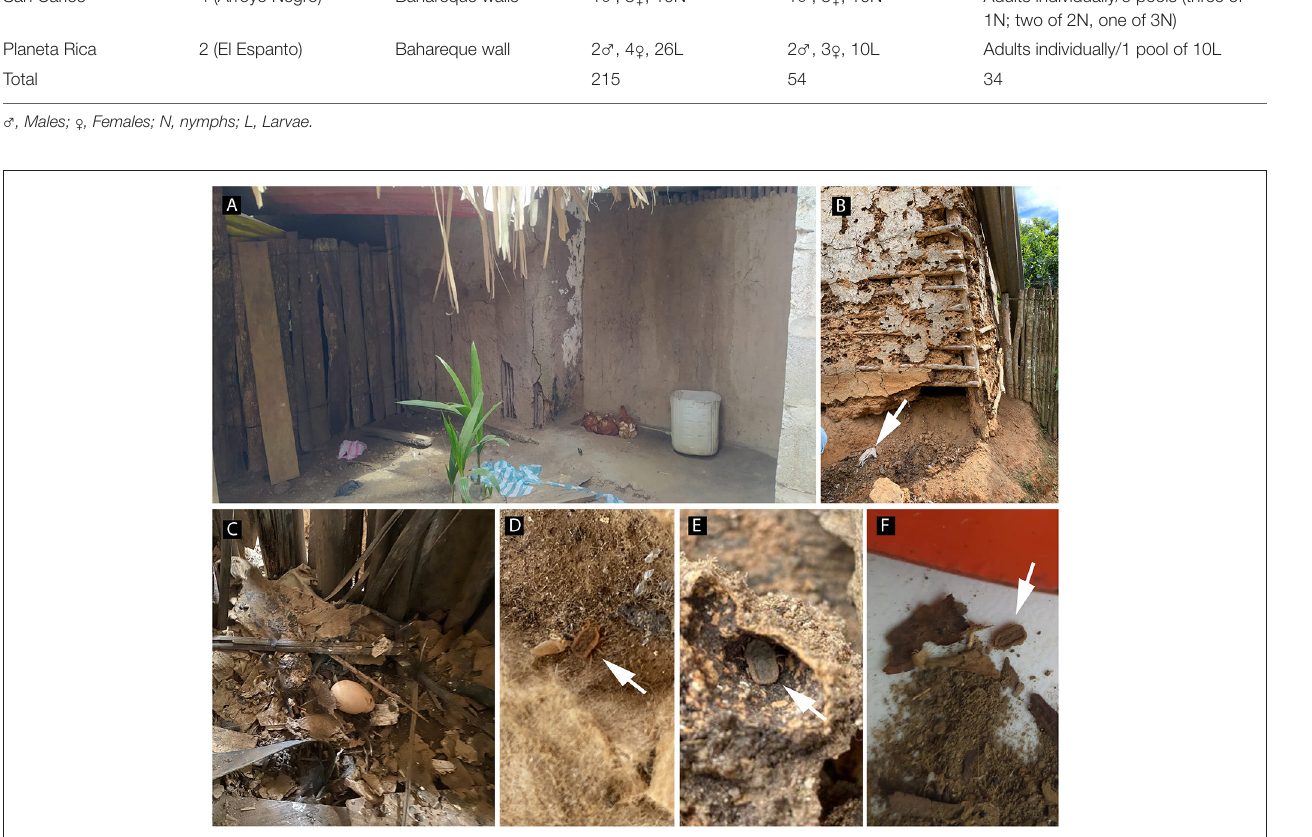
FIGURE 2 | Dwellings where soft ticks were collected in the Córdoba department, Colombia. (A) Chickens lying adjacent to an external bahareque wall in locality 4 (Arroyo Negro); (B) Bahareque construction; note the crevices on the wall and the bird nest (arrow) in locality 2 (El Espanto); (C) chicken nest adjacent to the